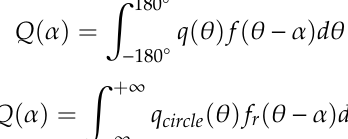
Figure 9. Schematic of electrode rotation.